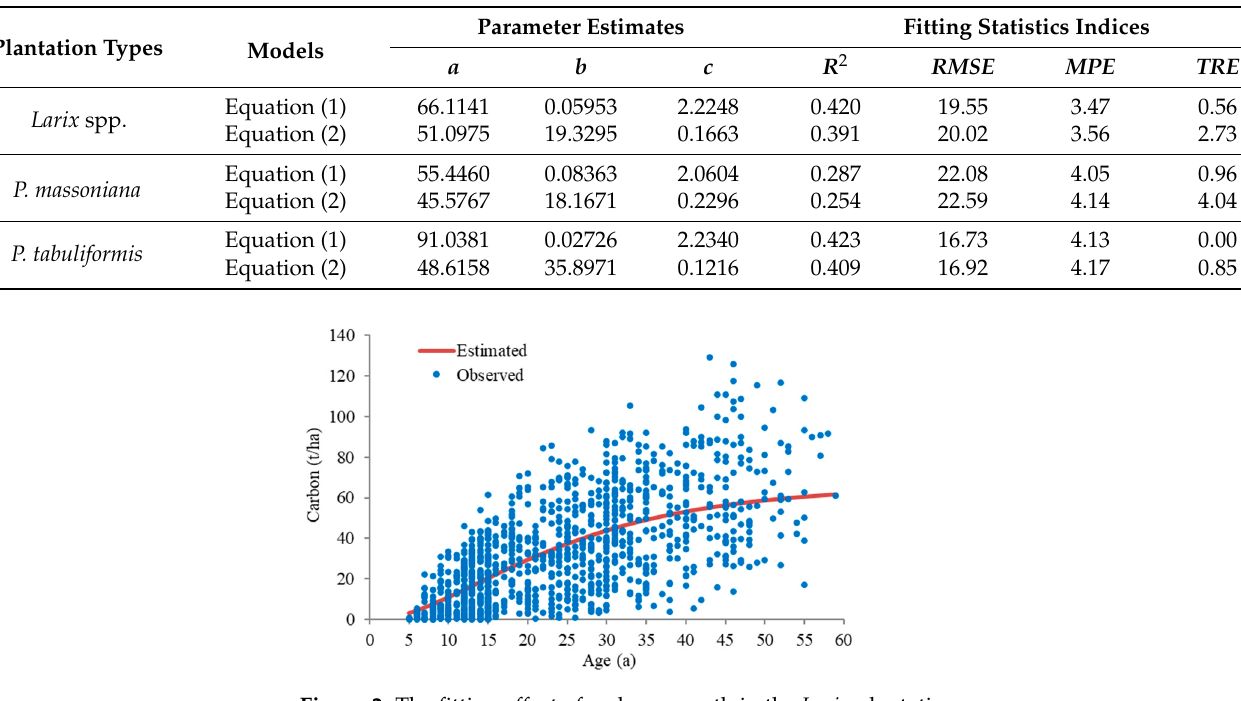
Figure 3. The fitting effect of carbon growth in the P. massoniana plantation. Figure 4. The fitting effect of carbon growth in the P. tabuliformis plantation. Figure 5. The average growth process of carbon storage for the three plantations.